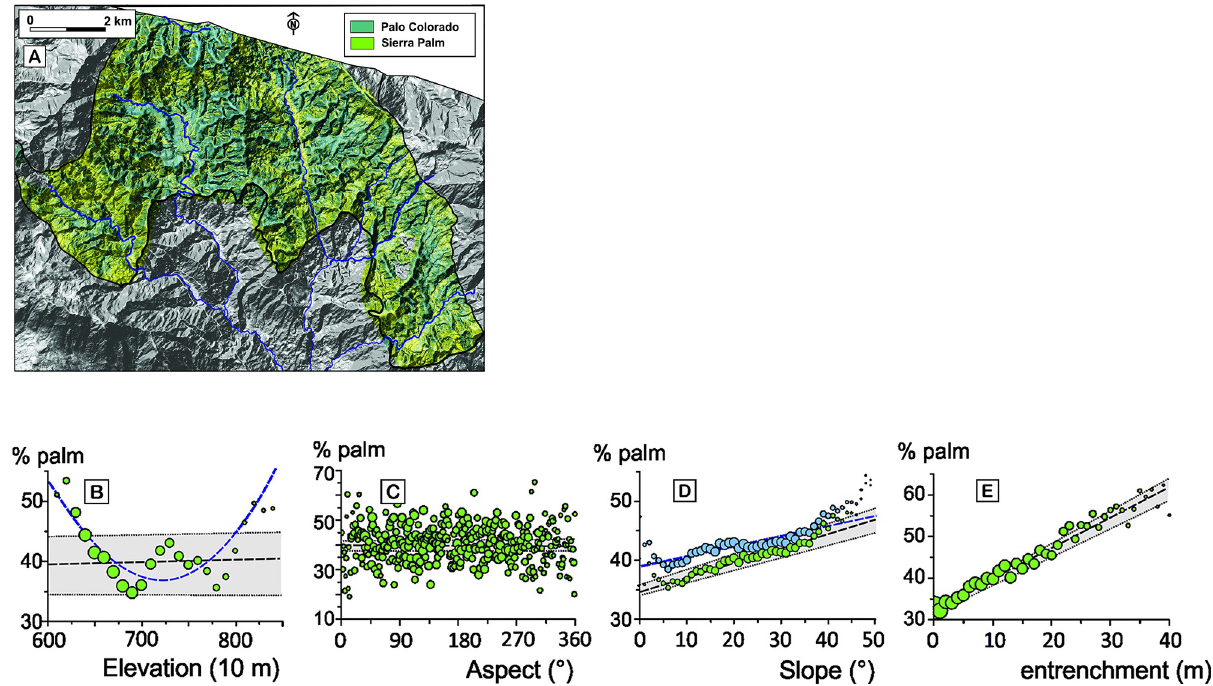
Fig 4. Correlation between topography and forest composition. A: composite classified satellite image of vegetation. Variations of Palm forest, as a function of elevation (B), aspect (C), slope steepness (D), and entrenchment, i.e., sheltering behind hilltops (E) (S2 Table 1 in S2 File). Circle areas are proportional to the areas of forest contributing to each bin of elevation (10m), aspect (1˚), slope (1˚), and depth (1 m). Dashed lines: linear regressions. Dotted lines bracketing shaded areas: 2 σ envelopes. Dashed blue line: second order polynomial regression on elevation (B), and linear regression including floodplains and volcanoclastic aprons (blue circles,